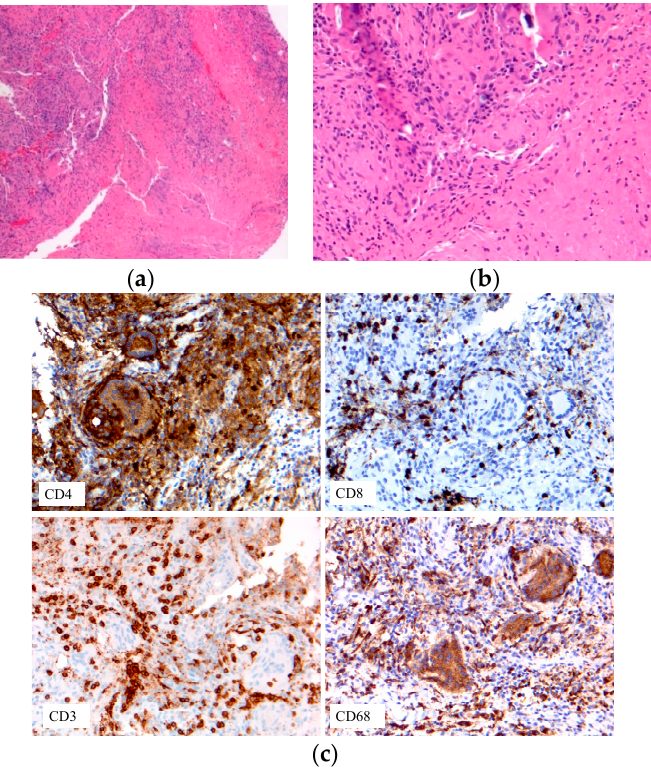
Figure 7. Immune cell phenotypes: T-cells: CD3, CD4, CD8; macrophage CD68. ( a ) Early onset sarcoidosis (EOS) skin sarcoidosis; ( b – c ) EOS skin sarcoidosis.